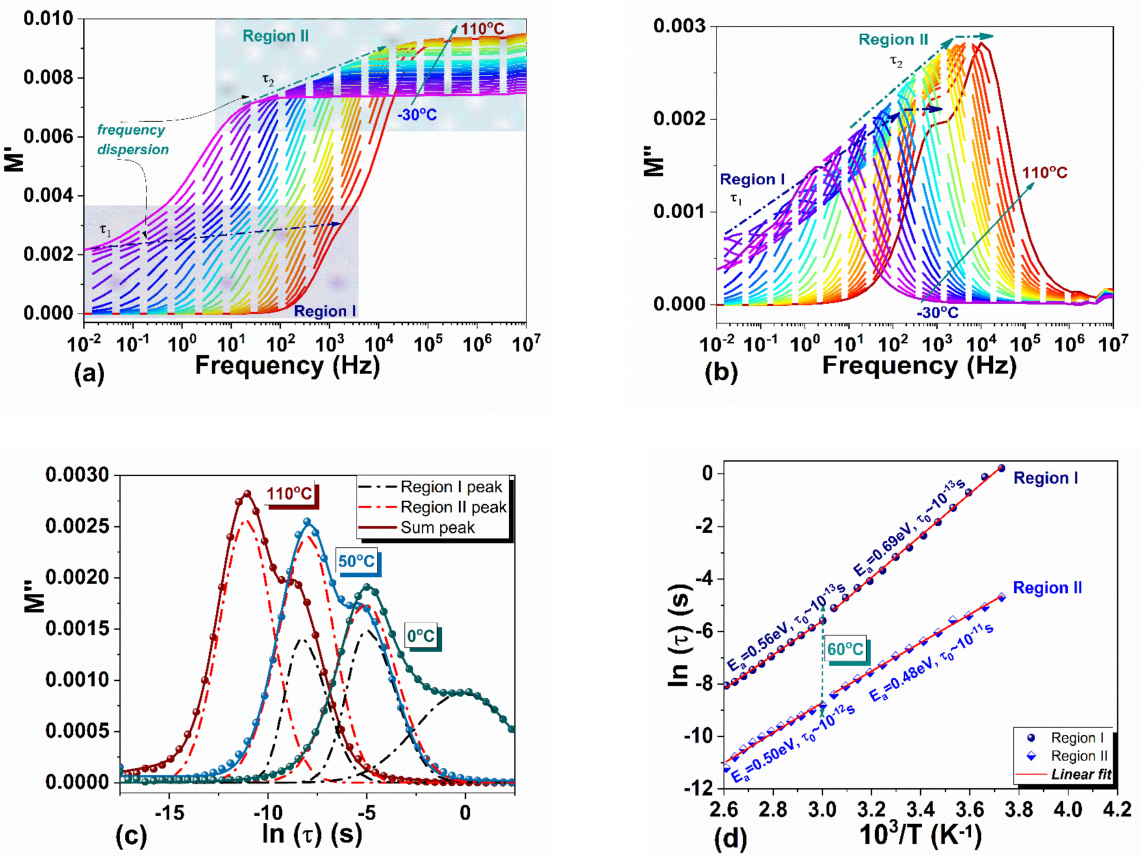
Figure 10. Complex modulus M * and relaxation time between − 30 ◦ C and 110 ◦ C: ( a ) M (cid:48) ( ν ) ; ( b ) M (cid:48)(cid:48) ( ν ) ; ( c ) Gaussian fit of the maxima in M ”; ( d ) relaxation time during